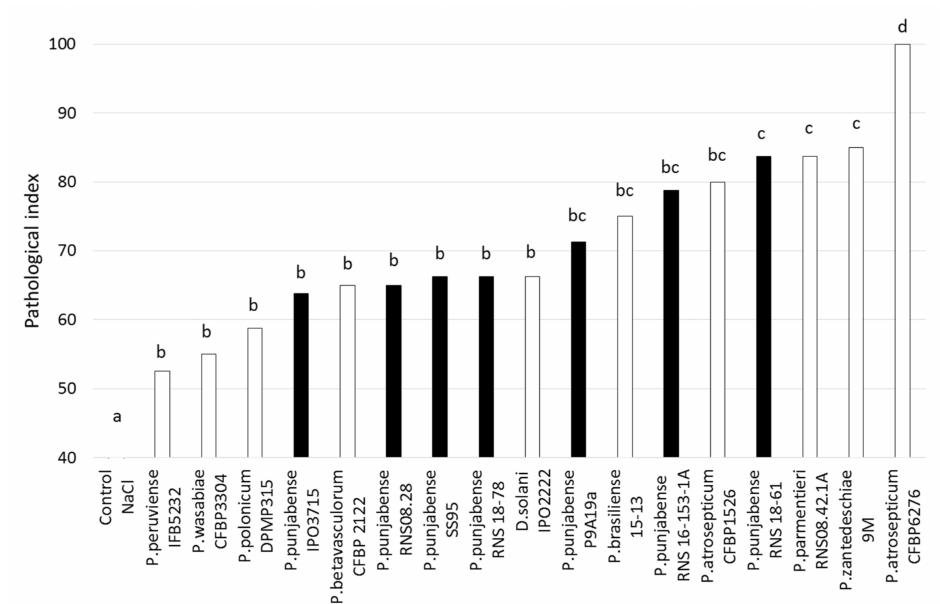
Figure 4. Soft rot index in a potato tuber assay comparing P. punjabense strains (in black) to other representative Pectobacterium strains (in white). Different lowercase letters above bars indicate statistically significant differences (Tukey HSD test, p =